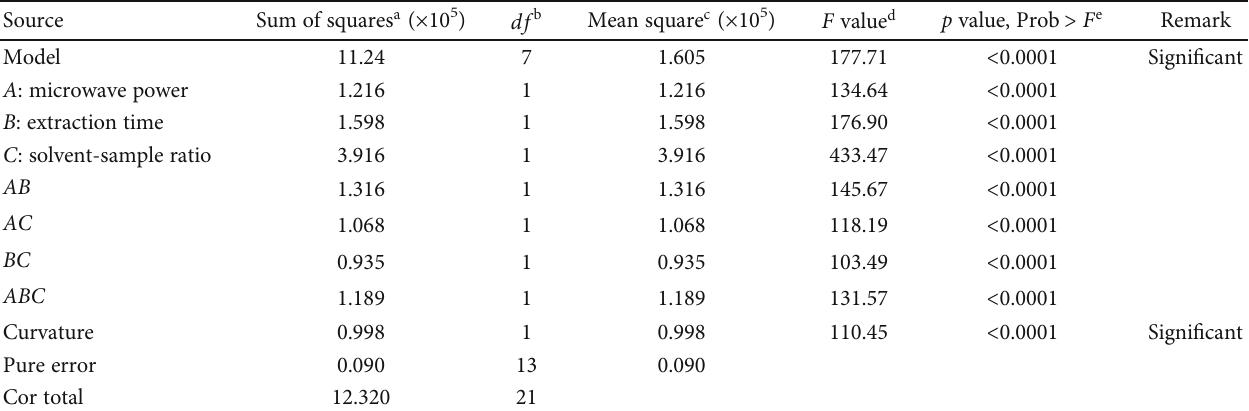
Table 4: ANOVA of two-level FFD.